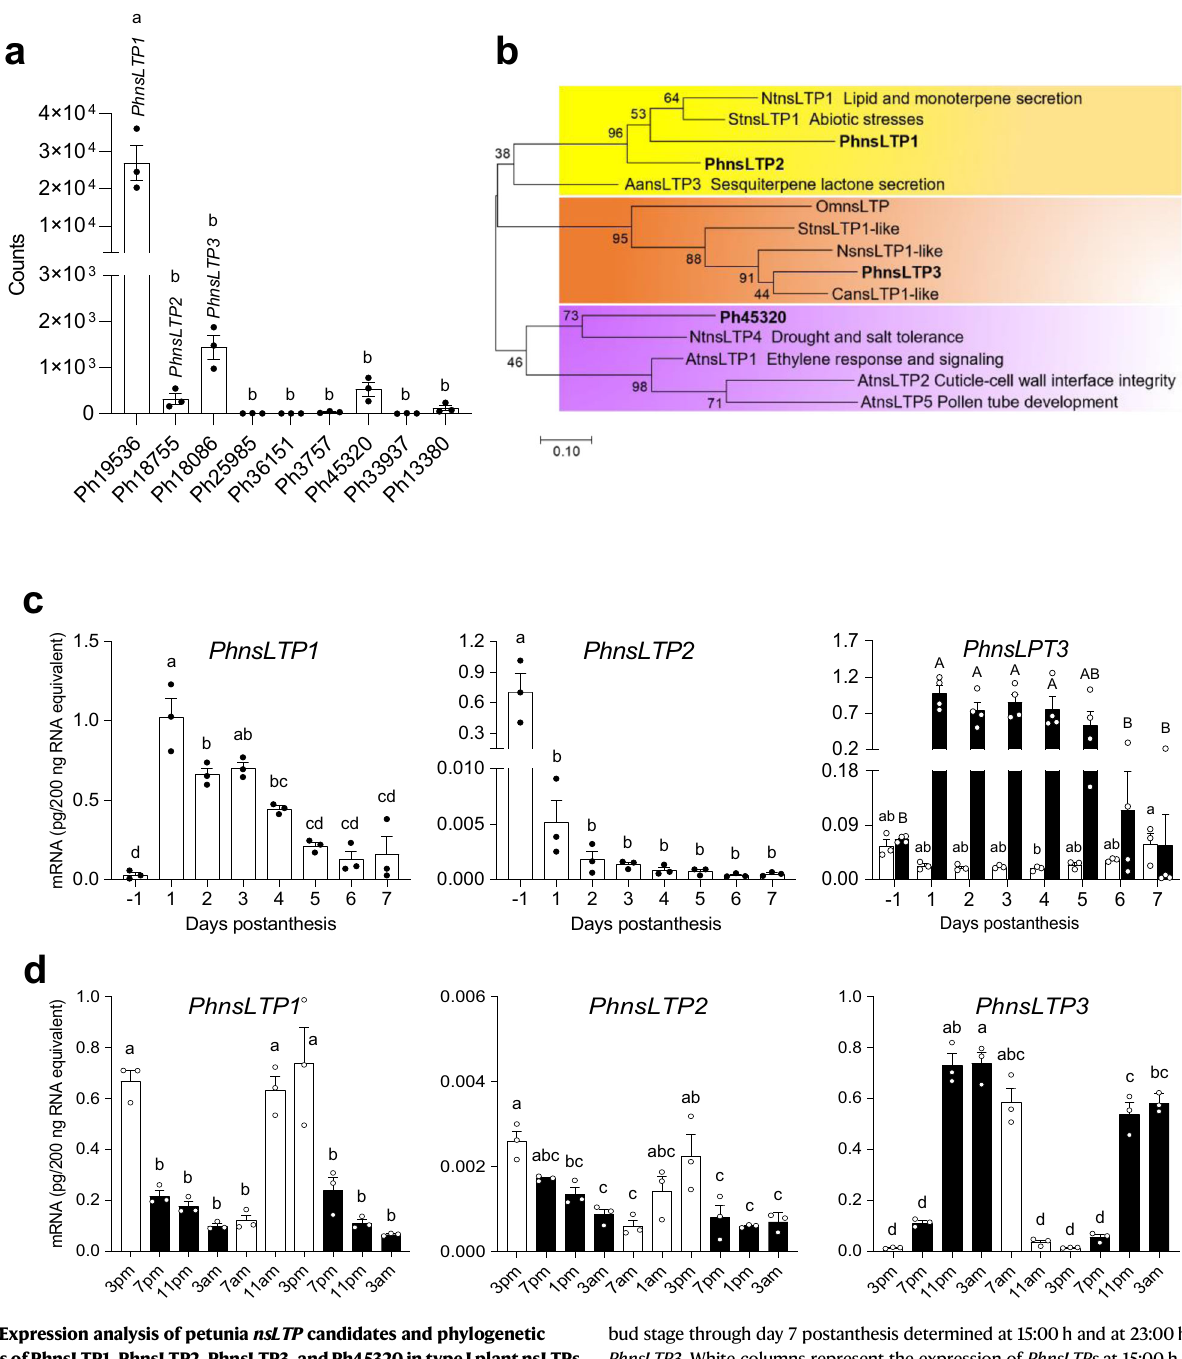
bud stage through day 7 postanthesis determined at 15:00h and at 23:00h for PhnsLTP3 . White columns represent the expression of PhnsLTPs at 15:00h during fl ower development, black columns indicate the PhnsLTP3 expression at 23:00h during fl ower development. d Changes in PhnsLTPs mRNA levels during a normal light/darkcycleinpetuniacorollasfromday1today3postanthesis.Whiteandblack columns correspond to light and dark periods, respectively. In c and d absolute mRNA levels were determined by qRT – PCR with gene-speci fi c primers and are shown as pg/200ng total RNA. Data are means±S.E. ( n =3 biological replicates in c and d ,and n =4biologicalreplicatesfor PhnsLTP3 at23:00hin c ).Differentletters indicatestatisticallysigni fi cantdifferences( P <0.05)determinedbyone-wayANOVA withTukey ’ smultiplecomparisonstest.In c ,upper-caseletterswereusedtoindicate signi fi cant differences among PhnsLTP3 mRNA levels at 23:00h during fl ower development. The exact P- values are provided in the Source data fi